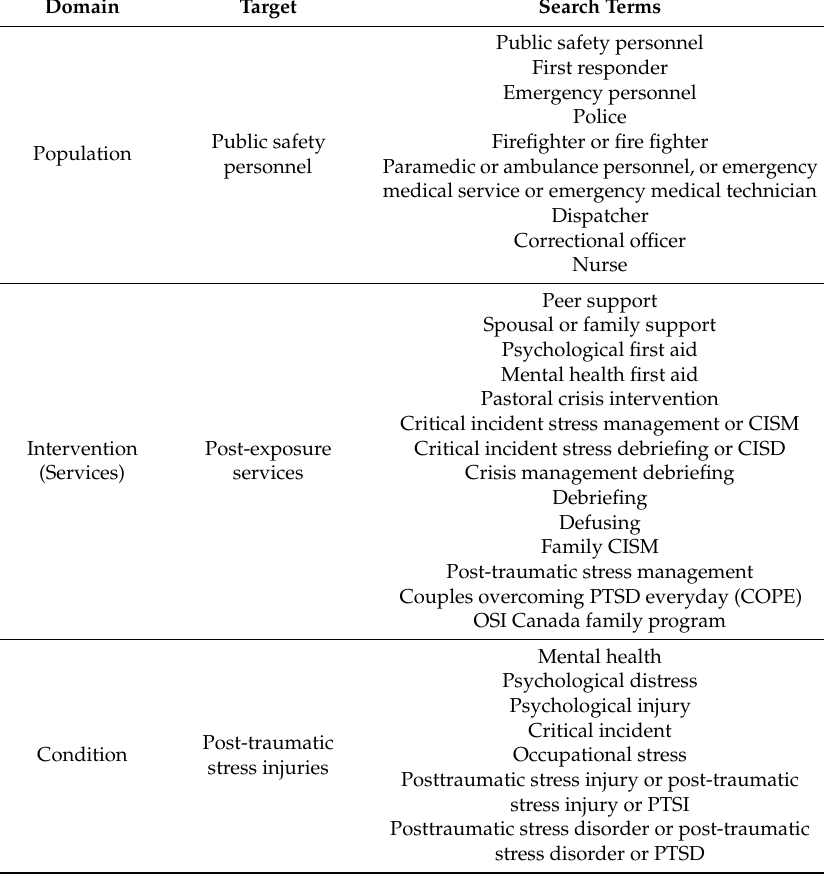
Table 1. Key terms used for database